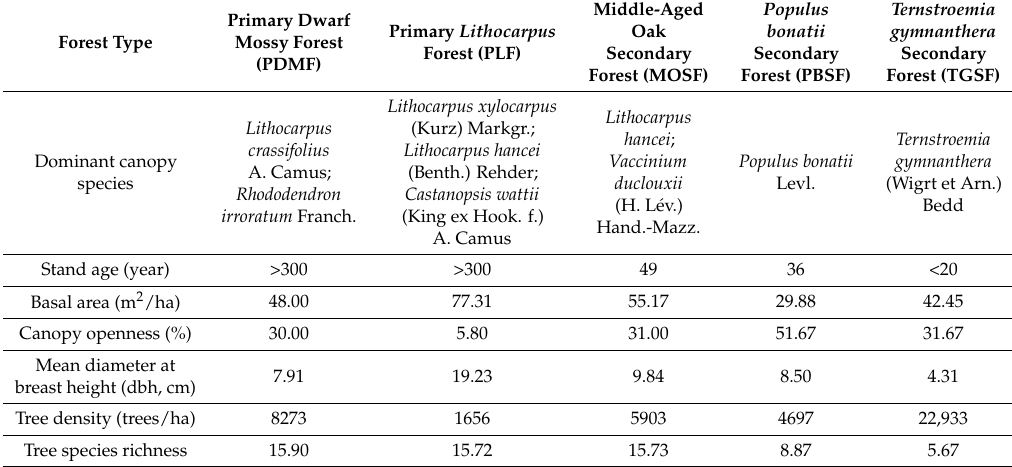
Table 1. Environmental conditions of five forest types in the Ailao Mountains, Southwest China.